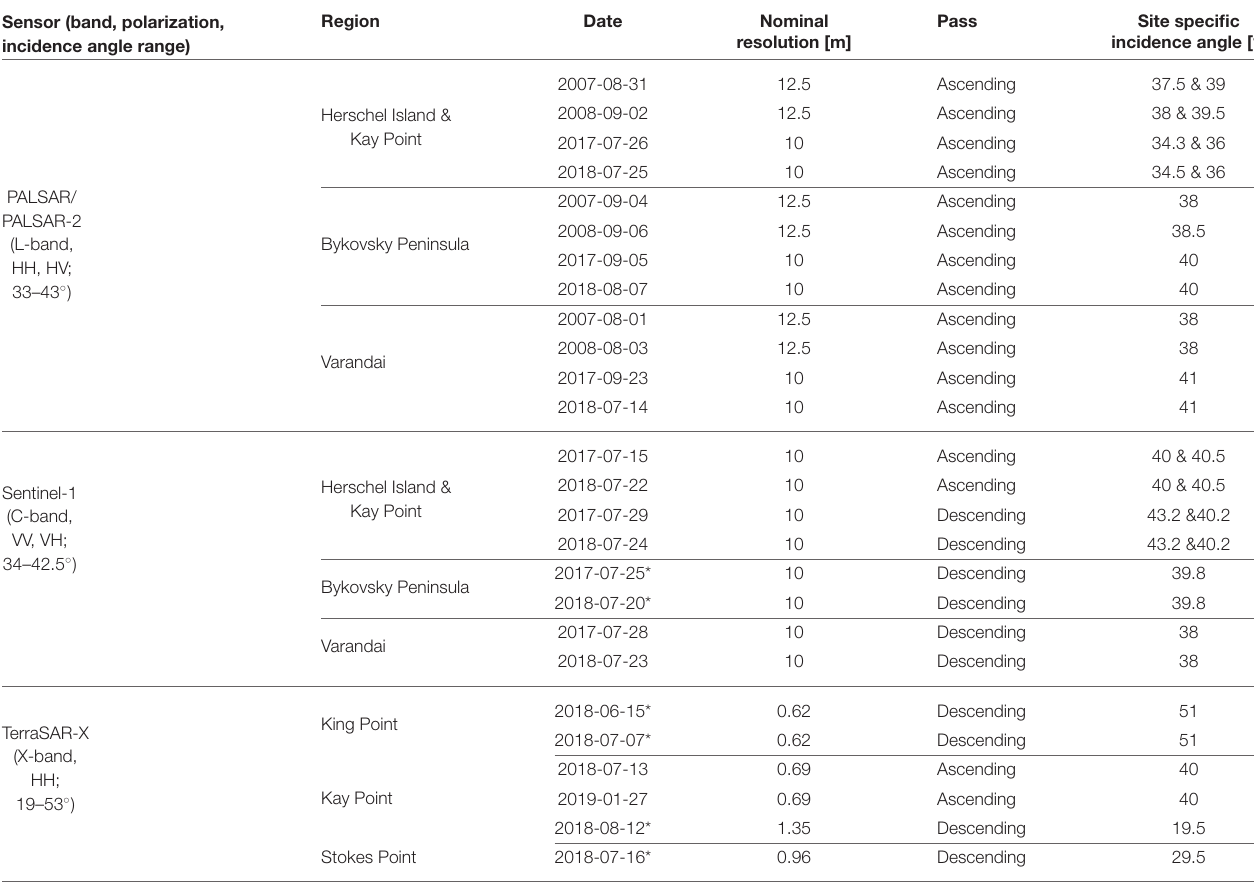
TABLE 1 | List of available Synthetic Aperture Radar acquisitions grouped by sensor and study area. Sensor (band, polarization, incidence angle range)